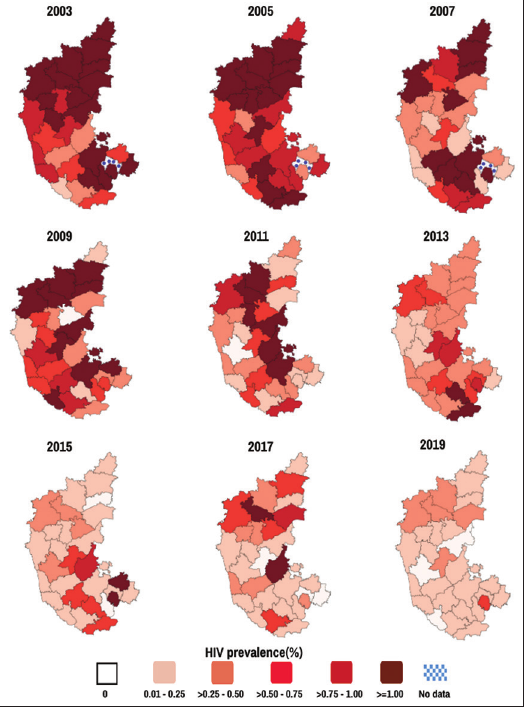
Figure 3: Geographical variation of HIV Prevalence (%) among pregnant women across the districts in Karnataka